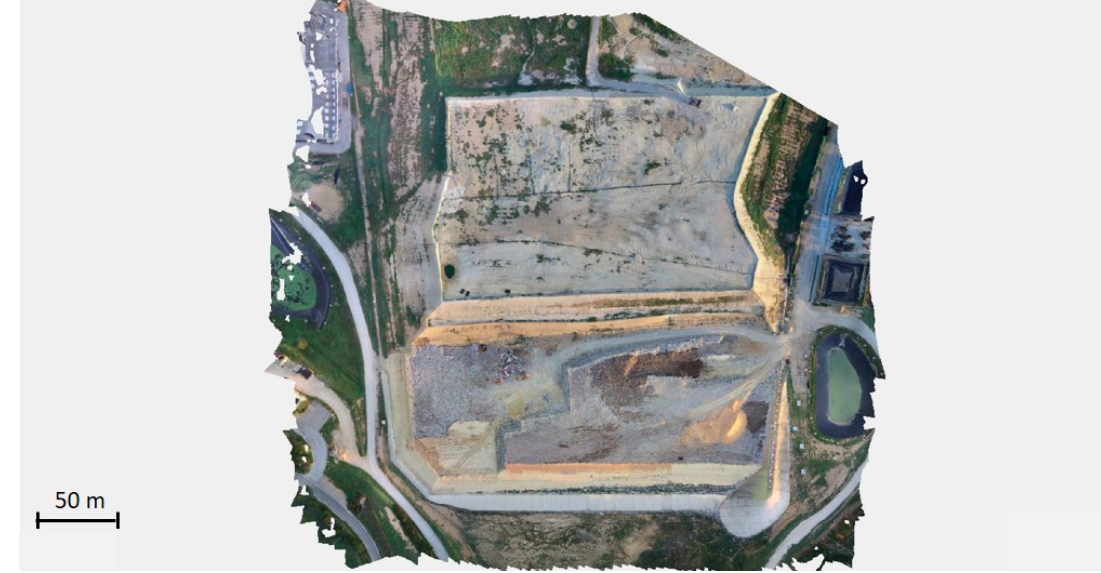
Figure 2. Topographic view of the landfill of Scala Erre, Sassari, Italy.